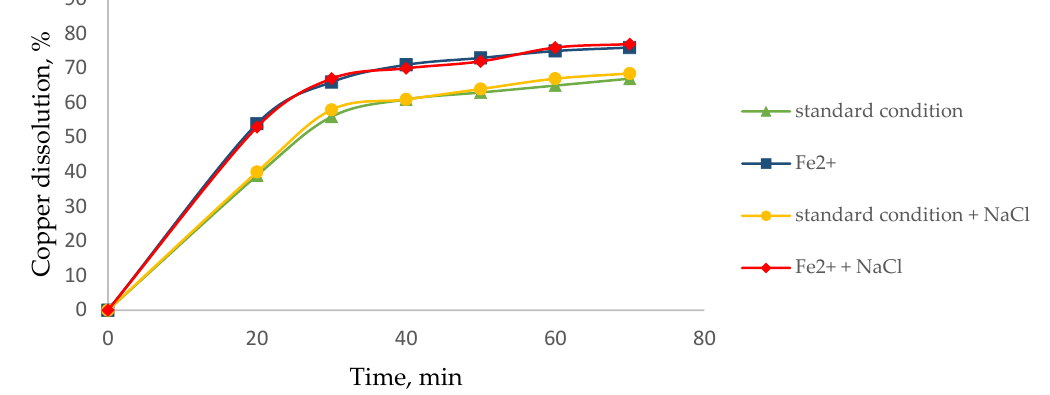
Figure 3. Dissolution of Cu from a black copper ore. Effect of NaCl concentration and cure time.